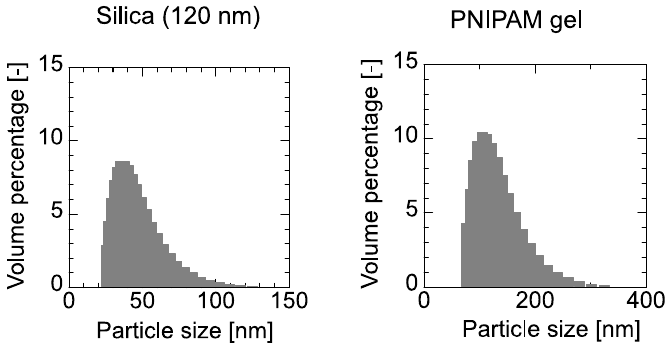
Figure A2. Supporting information, size distribution of silica and PNIPAM gel.